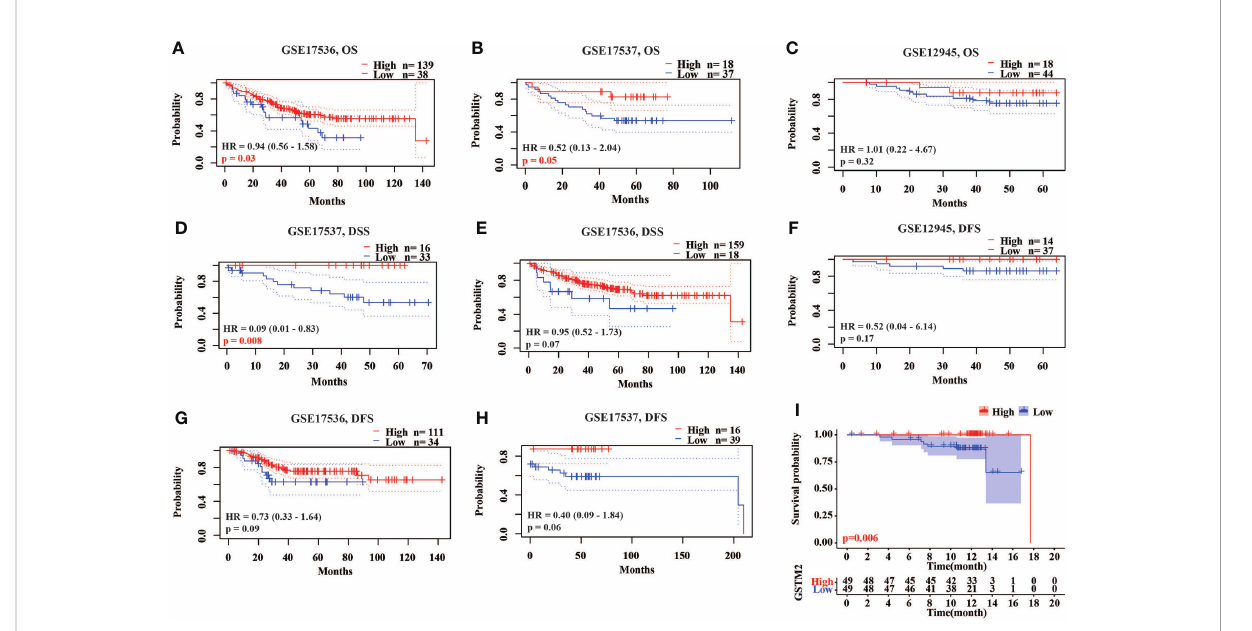
FIGURE 3 The Lower GSTM2 Expression Predicts Worse Prognosis of Colon Cancer Patients. (A – C) The correlation between the GSTM2 expression and OS of colon cancer patients using the GSE17536, GSE17537, GSE12945 datasets. (D – F) The correlation between the GSTM2 mRNA expression and DSS of colon cancer patients using the GSE17537, GSE17536, GSE12945 datasets. (G, H) The correlation between the GSTM2 mRNA expression and DFS of colon cancer patients using the GSE17536, GSE17537 datasets. (I) The correlation between the GSTM2 protein expression and OS of colon cancer patients using the dataset from